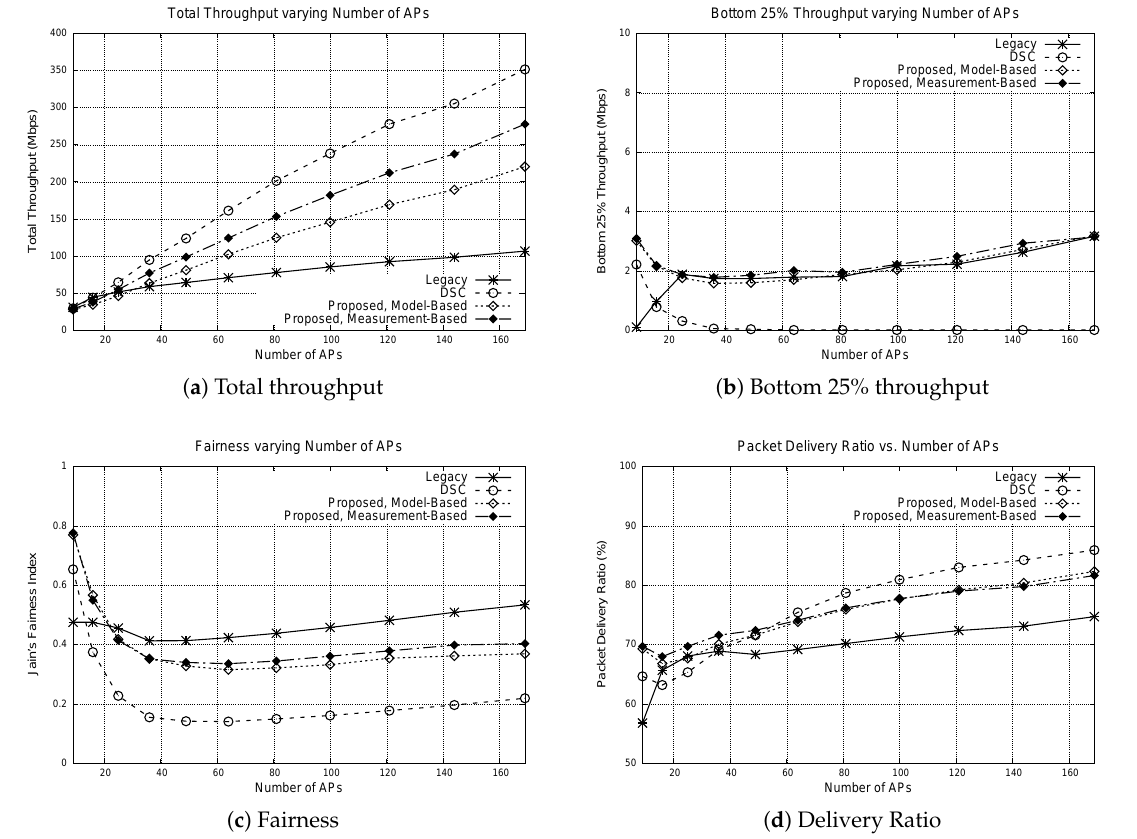
Figure 6. Performance of protocols varying number of APs. Number of APs is varied from 9 to 169, whereas the number of nodes is fixed to 100. ( a ) total throughput, ( b ) bottom 25% throughput, ( c ) Jain’s fairness index, ( d ) packet delivery